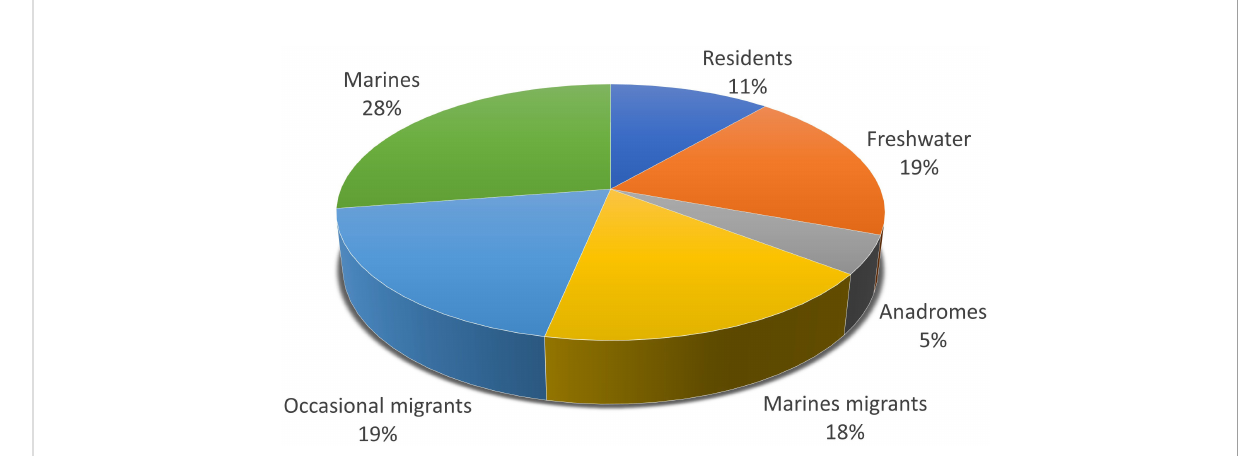
FIGURE 2 Pie-chart showing the percentage proportions of ecological guilds (Potter et al., 2015) of the species detected in the Venice Lagoon through eDNA